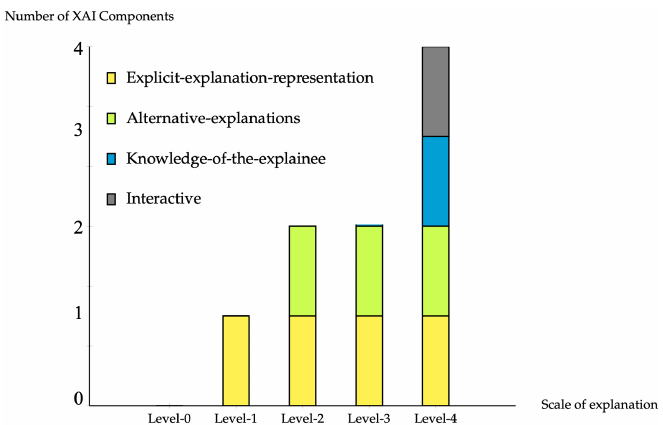
Figure 3. Major explanatory components (stacked bar) and their potential role in a scale of explana-